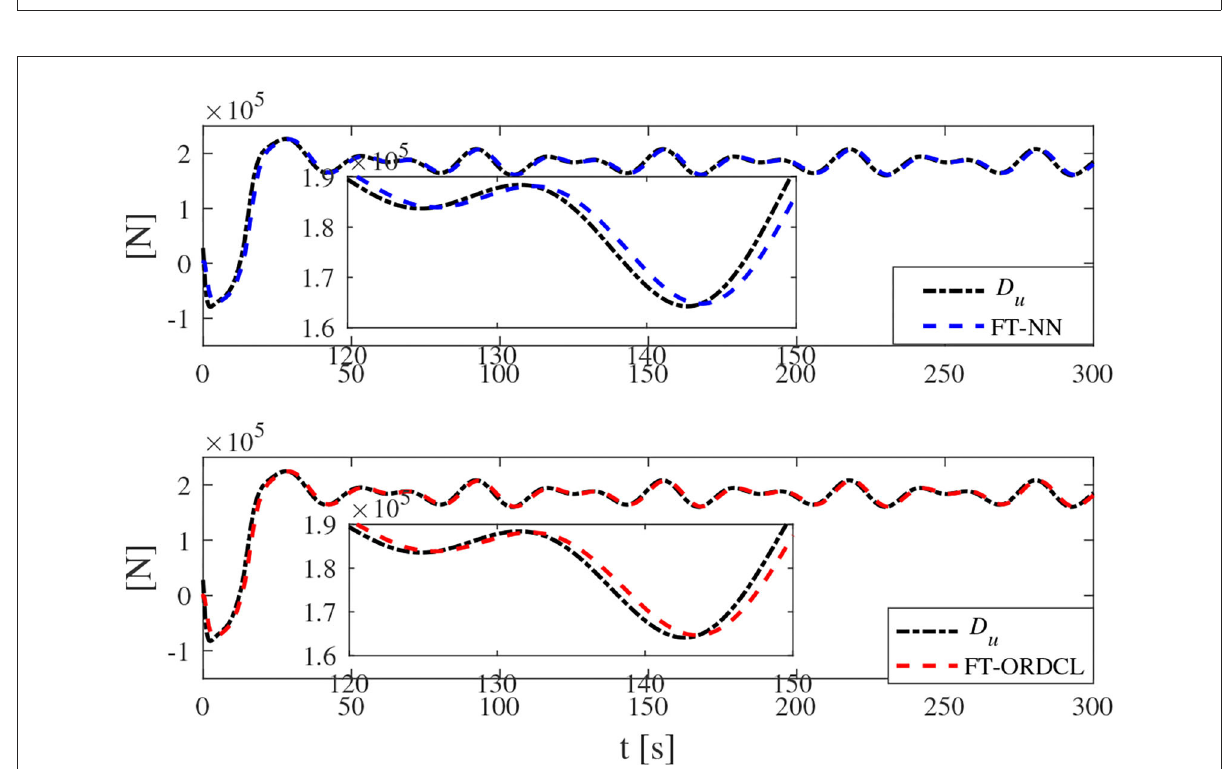
FIGURE9 D u and its estimation in Case